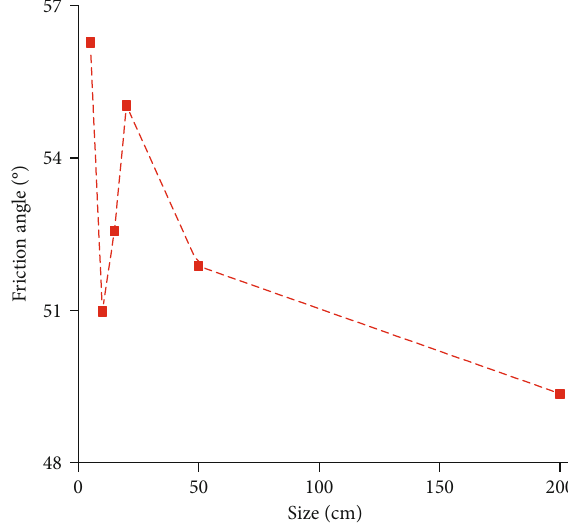
Figure 11: Relationship between friction angle and model size.